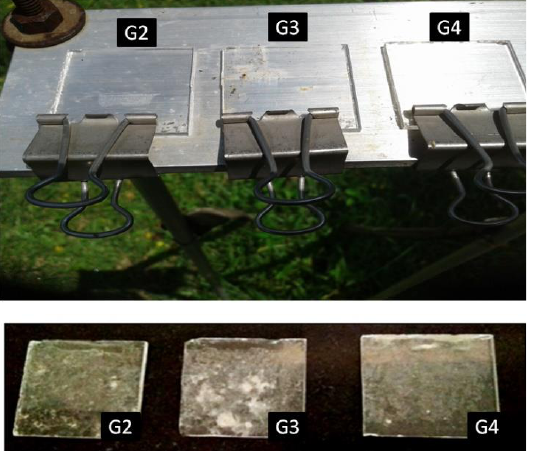
Figure 3. Photographs of the glass coupons placed outdoors having different cleaning cycles, weekly cleaned (G2), monthly cleaned (G3), and never cleaned (G4) (above), and an example of the non- uniform distribution of soiling observed, for example, at week 45 (below).